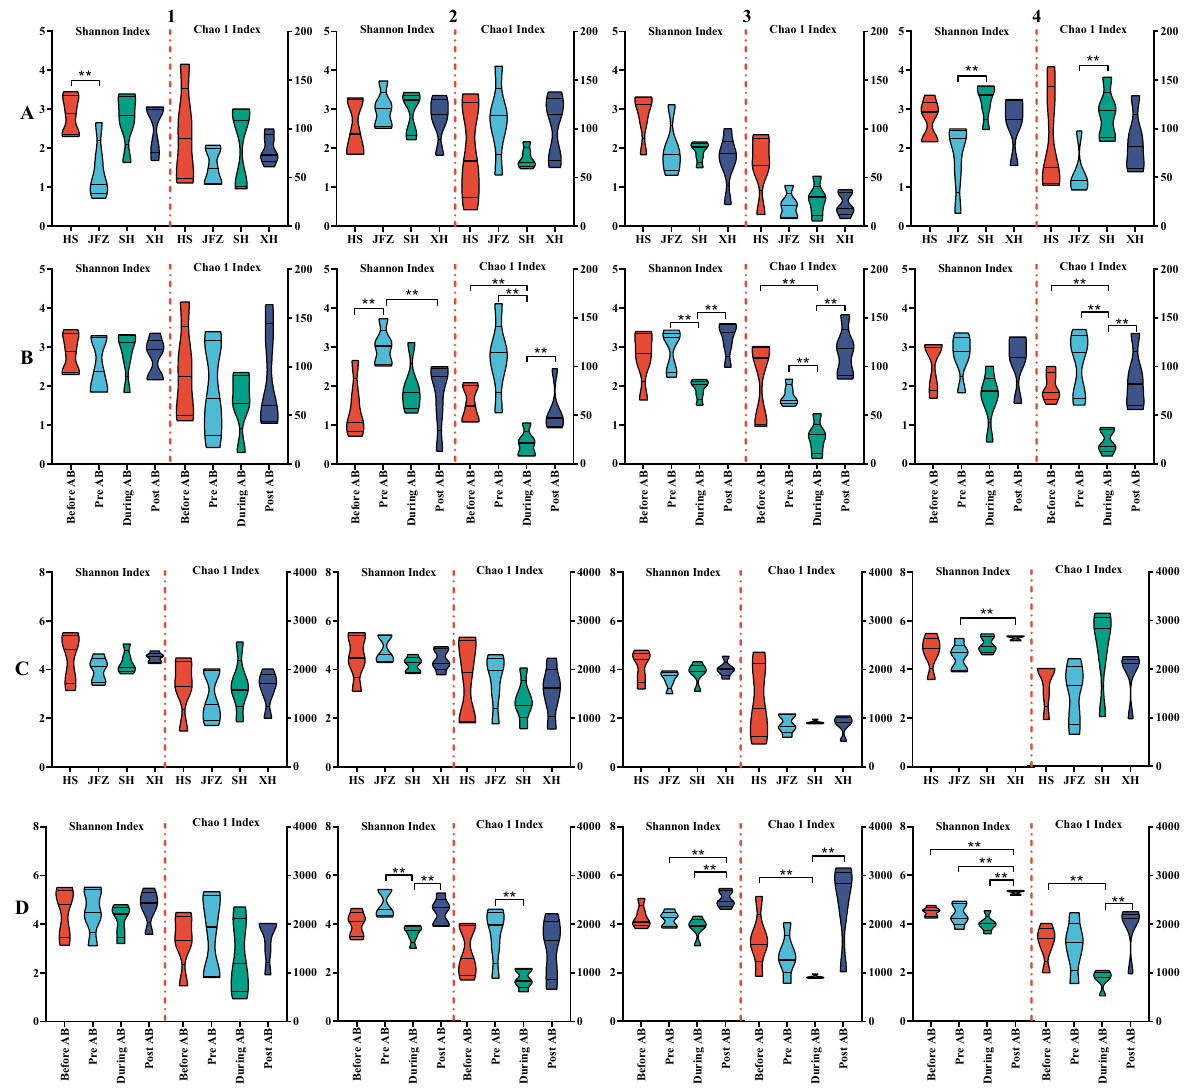
Figure 2. Comparisons of alpha-diversity estimators of Shannon and Chao1 on cyanobacterial ( A1 – A4 and B1 – B4 ) and bacterial communities ( C1 – C4 and D1 – D4 ). Figures of ( A1 – A4 ) illustrated cyanobacterial community diversity amongst different rivers at the same phases of Before AB ( A1 ), Pre AB ( A2 ), During AB ( A3 ), and Post AB ( A4 ), respectively; and ( B1-B4 ) showed cyanobacterial community diversity of HS ( B1 ), JFZ ( B2 ), SH ( B3 ), and XH ( B4 ) at different bloom phases. ( C1 – C4 ) and ( D1 – D4 ) represented comparisons of bacterial communities equivalent to ( A1 – A4) and ( B1 – B4